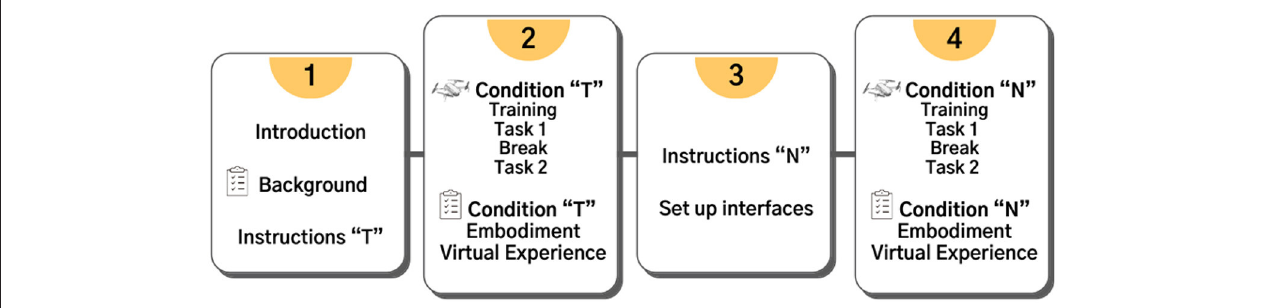
FIGURE 9 | The four phases of the experiment. The order of the conditions T and N (and the related instructions preceding them) were differentiated for the two groups of participants.